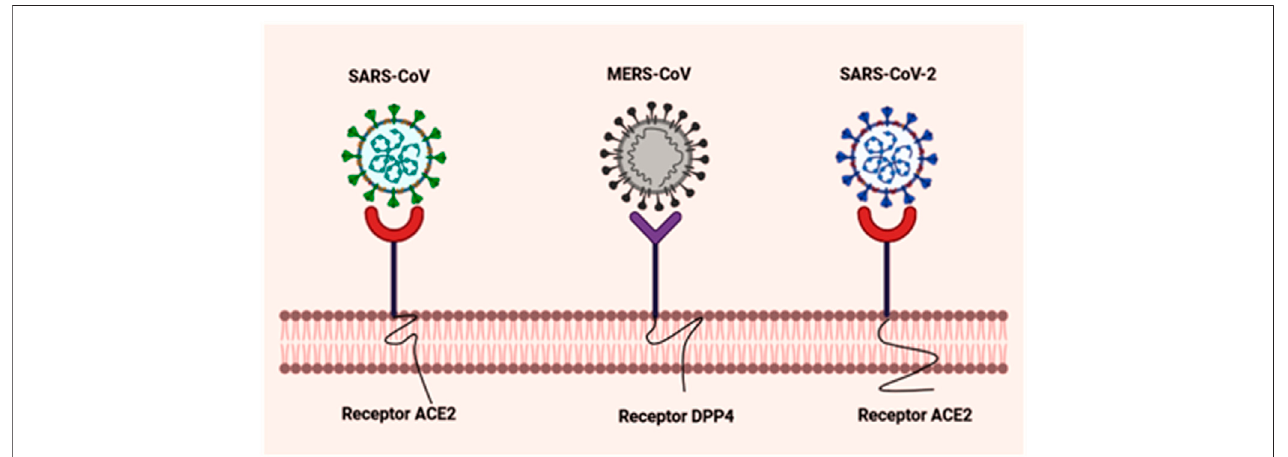
FIGURE 1 | Schematic representation of molecular interaction between virus and host cellular receptors. The graphical representation portrays the S protein of SARS-CoV and MERS-CoV that interacts with the host cellular receptors ACE2 and DPP4, respectively. Novel SARS-CoV-2 also leverages human ACE2 as its target receptor for cellular entry, similar to SARS-CoV. Created with BioRender.com.